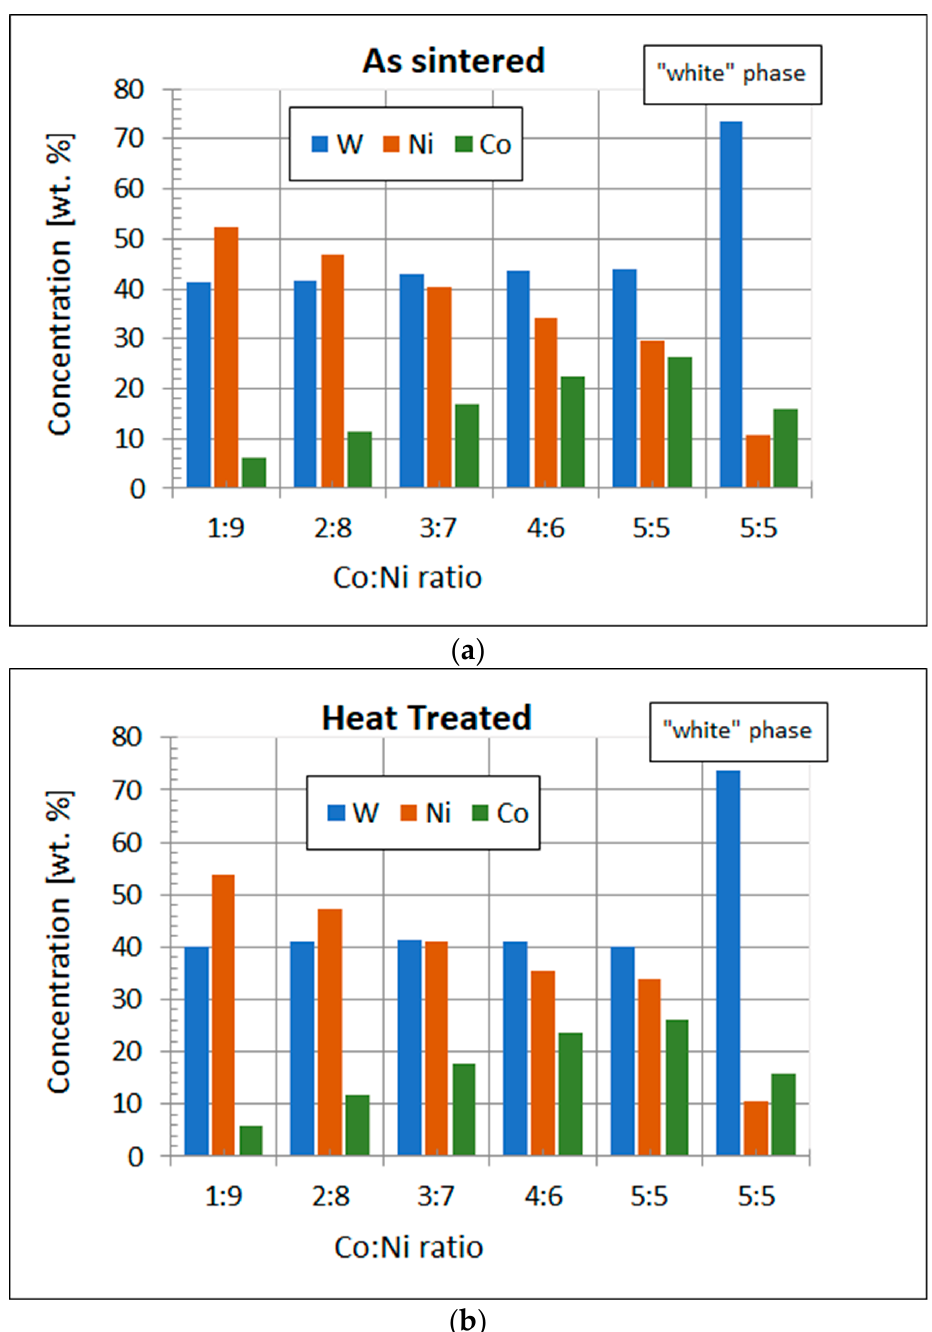
Figure 6. The concentration of W, Ni, and Co in alloys with different Co:Ni ratios: ( a ) as sintered; ( b ) heat treated for 3 h at 1200 °C.